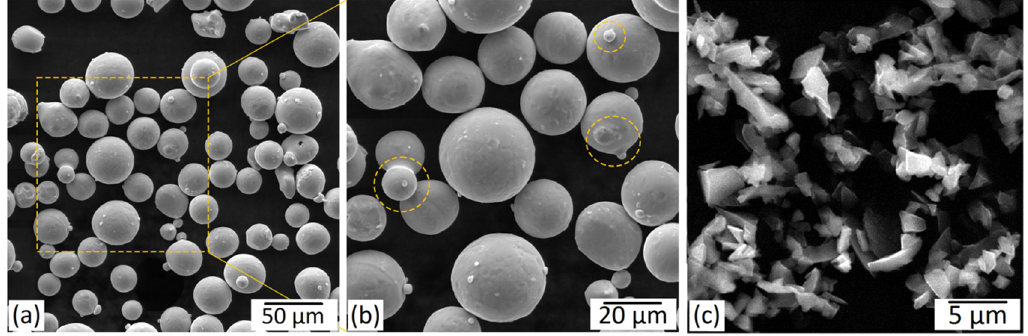
Figure 3. SEM micrographs of starting: ( a , b ) Ti-6Al-4V (host) and ( c ) B 4 C (guest) powder particles. ( b ) Higher ‐ magnification micrographs of the selected region in ( a ). The circles in ( b ) indicate the satellites. The micrographs of the regularly mixed and ball-milled composite powders subjected to various mixing times are provided in Figures 4 and 5, respectively.